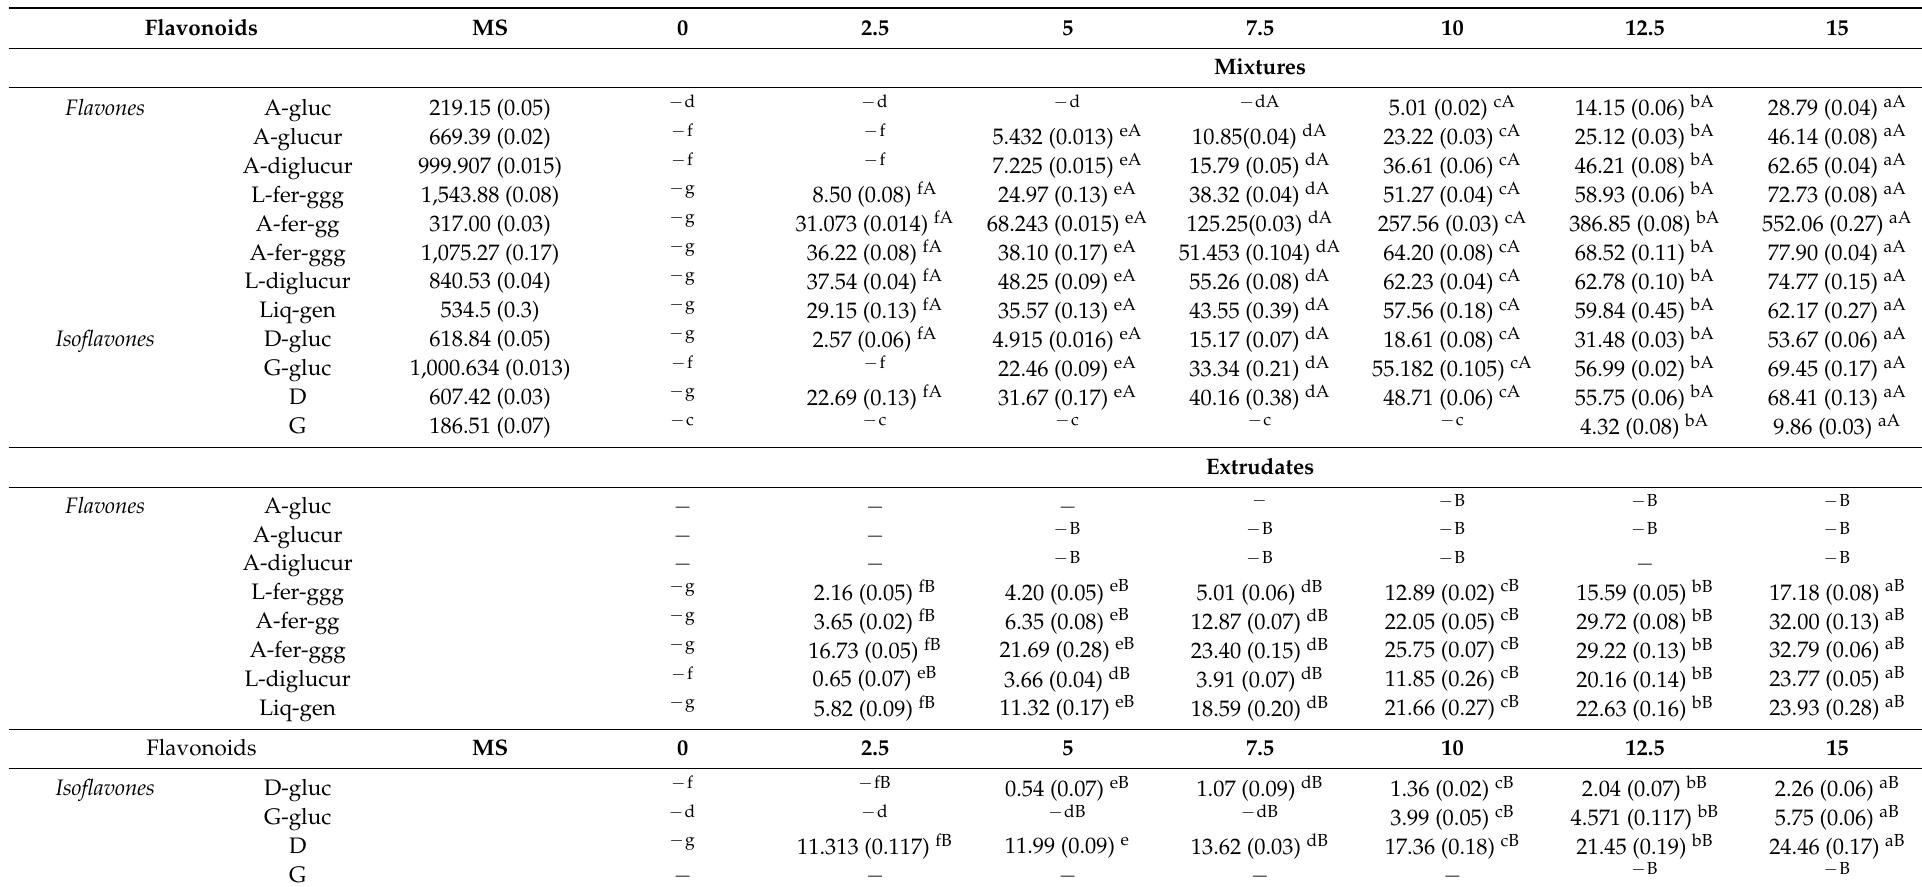
Table 5. Mean values (and standard deviations) of flavonoids A-gluc (Apigenin-glucoside), A-glucur (Apigenin-glucuronide), A-diglucur (Apigenin-diglucuronide), L-fer-ggg (Luteolin- (feruloyl-glucuronyl-glucuronyl)-glucuronide), A-fer-gg (Apigenin-(feruloyl-glucuronyl)-glucuronide), A-fer-ggg (Apigenin-(feruloyl-glucuronyl-glucuronyl)-glucuronide), L-diglucur (Luteolin-diglucuronide), Liq-gen (Liquirtigenin), D-gluc (Daidzein-glucoside), G-gluc (Genistein-glucoside), D (Daidzein), and G (Genistein) content ( µ g/g dry weight ) of Medicago sativa, corn mixtures, and extrudates with 0–15%